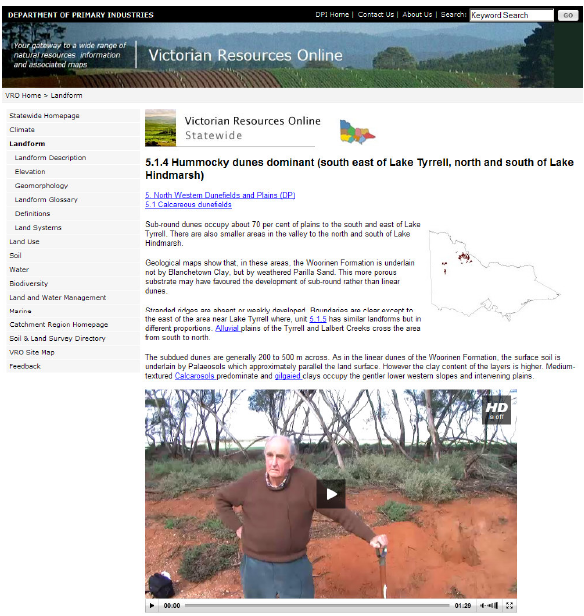
Figure 6. On-line video clip of retired expert (Jim Rowan) describing landscape features in the